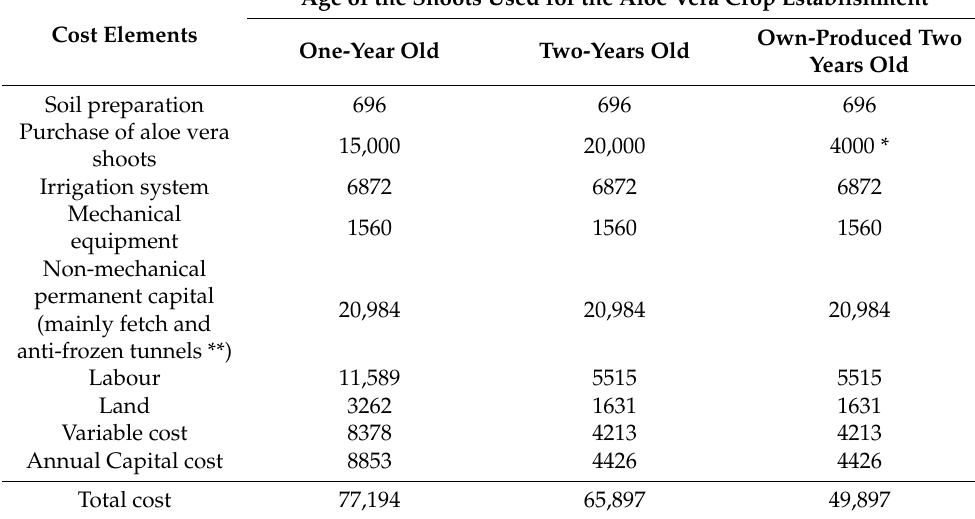
Table 3. Establishment cost of an organic aloe vera farm in Greece ( €